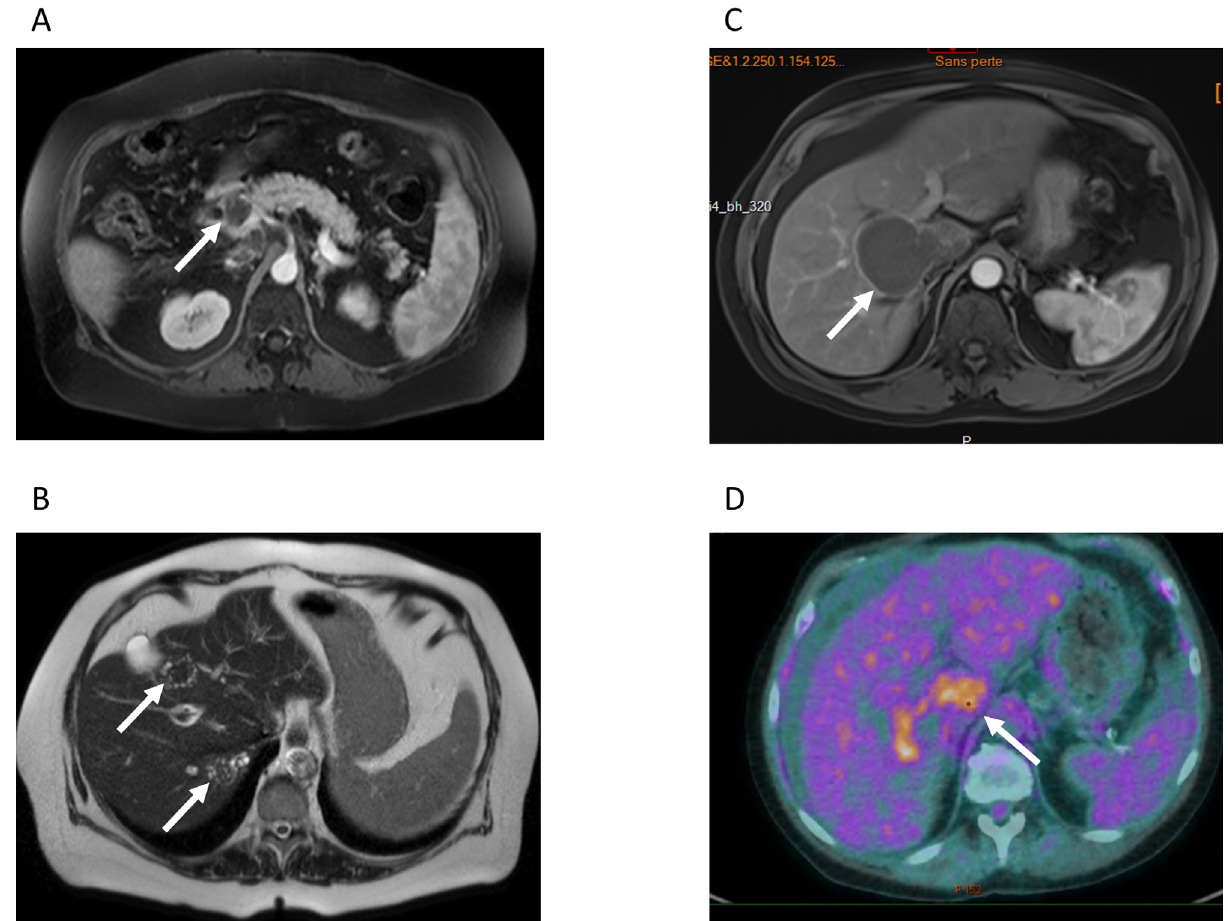
Figure 1. Radiological fi ndings. A) and B) MRI of patient #5 A) T1-weighted MRI of patient #5. White arrow: lesion in the head of the pancreas. This lesion was mistakenly interpreted as pancreatic cancer. B) T2-weighted, the white arrows point at the typical microcysts in T2-hypersignal. C) T1-weighted MRI of patient #4, showing a large well-delimited lesion tumor-like lesion, with invasion of the right portal branch D) PET-CT of patient #4, showing intense metabolic activity at the periphery of the